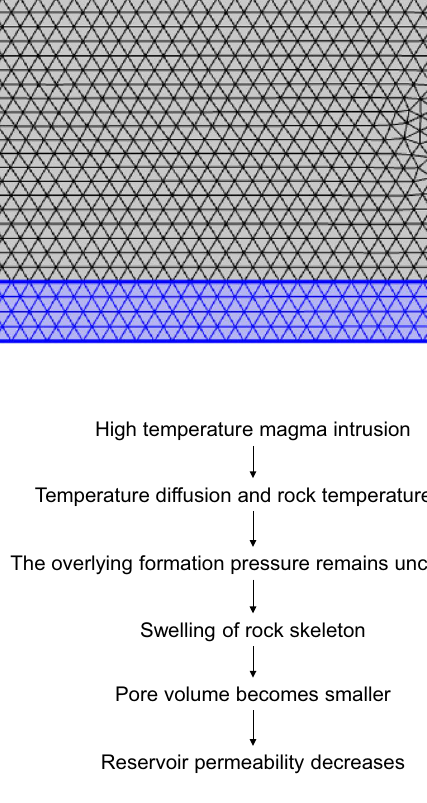
Fig. 4 Research roadmap for the mechanism of igneous rocks on